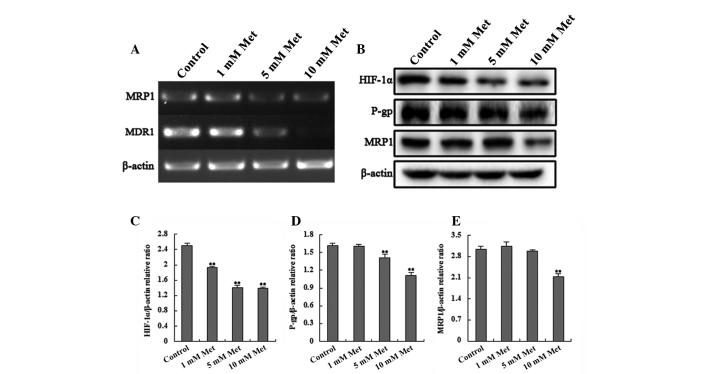
Met affects the expression of HIF-1α, MDR1/P-gp and MRP1. (A) Reverse transcription-polymerase chain reaction analysis of MDR1 and MRP1 expression in the different treatment groups. (B) Western blot analysis of HIF-1α, MDR1 and MRP1 in the different treatment groups. (C–E) Relative density of the western blotting bands demonstrated that levels of HIF-1α, P-gp and MRP1 decreased with increasing concentrations of Met in a dose-dependent manner, with a statistically significant difference between the treatments and the controls (**P <0.01, compared with the control). P-gp and MRP1 protein band densities were normalized to their corresponding β-actin bands. (**P<0.01, compared with the control). HIF-1α, hypoxia-inducible factor-1α; MDR1, multidrug resistance-associated protein 1; P-gp, P-glycoprotein; MRP1, multidrug resistance protein 1; Met, metformin.